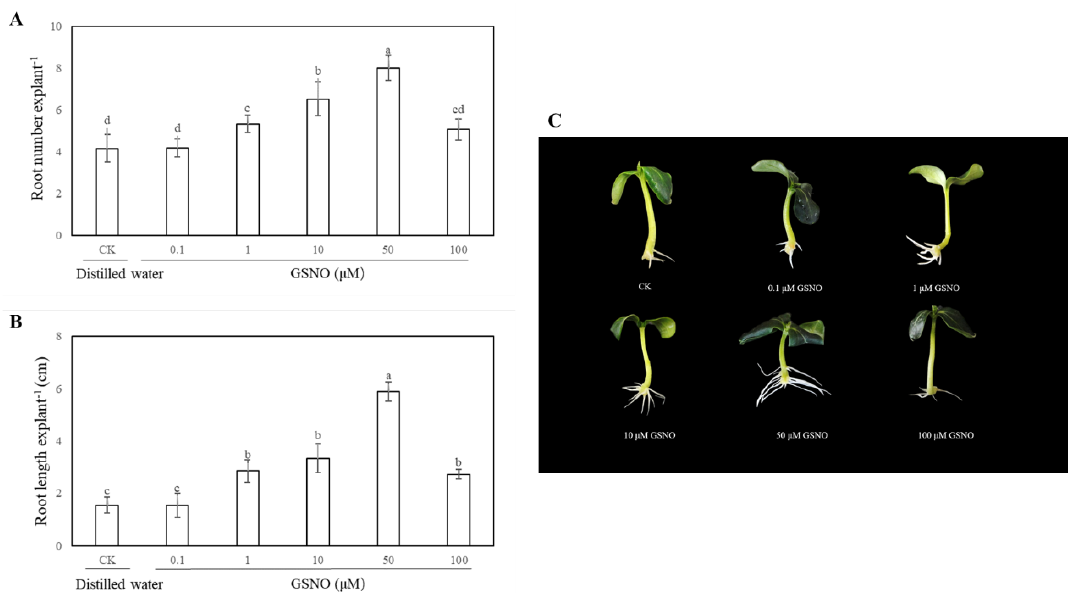
Figure 1. Effect of different concentrations of S -nitrosoglutathione (GSNO) on adventitious root development in cucumber explants. The primary roots were removed from hypocotyl of 5-day-old seedlings. Explants were incubated for 5 days with different concentrations of GSNO. The numbers ( A ) and root length ( B ) of adventitious roots were expressed as mean ± SE ( n = 3). Ten explants were used per replicate. Photographs ( C ) were taken after five days of the treatments indicated. Bars with different lowercase letters were significantly different by Duncan’s multiple range test ( p < 0.05). Bars with different lowercase letters were significantly different by Duncan’s multiple range test.